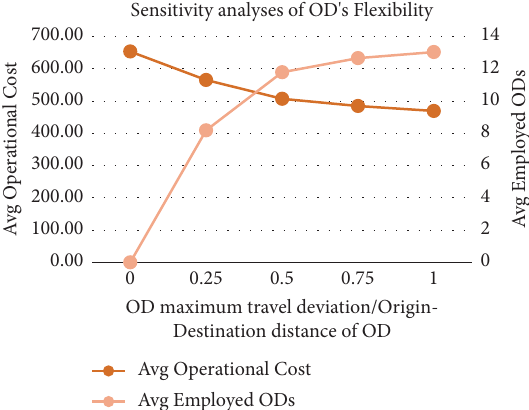
Figure 5: Sensitivity analyses of the fexibility of